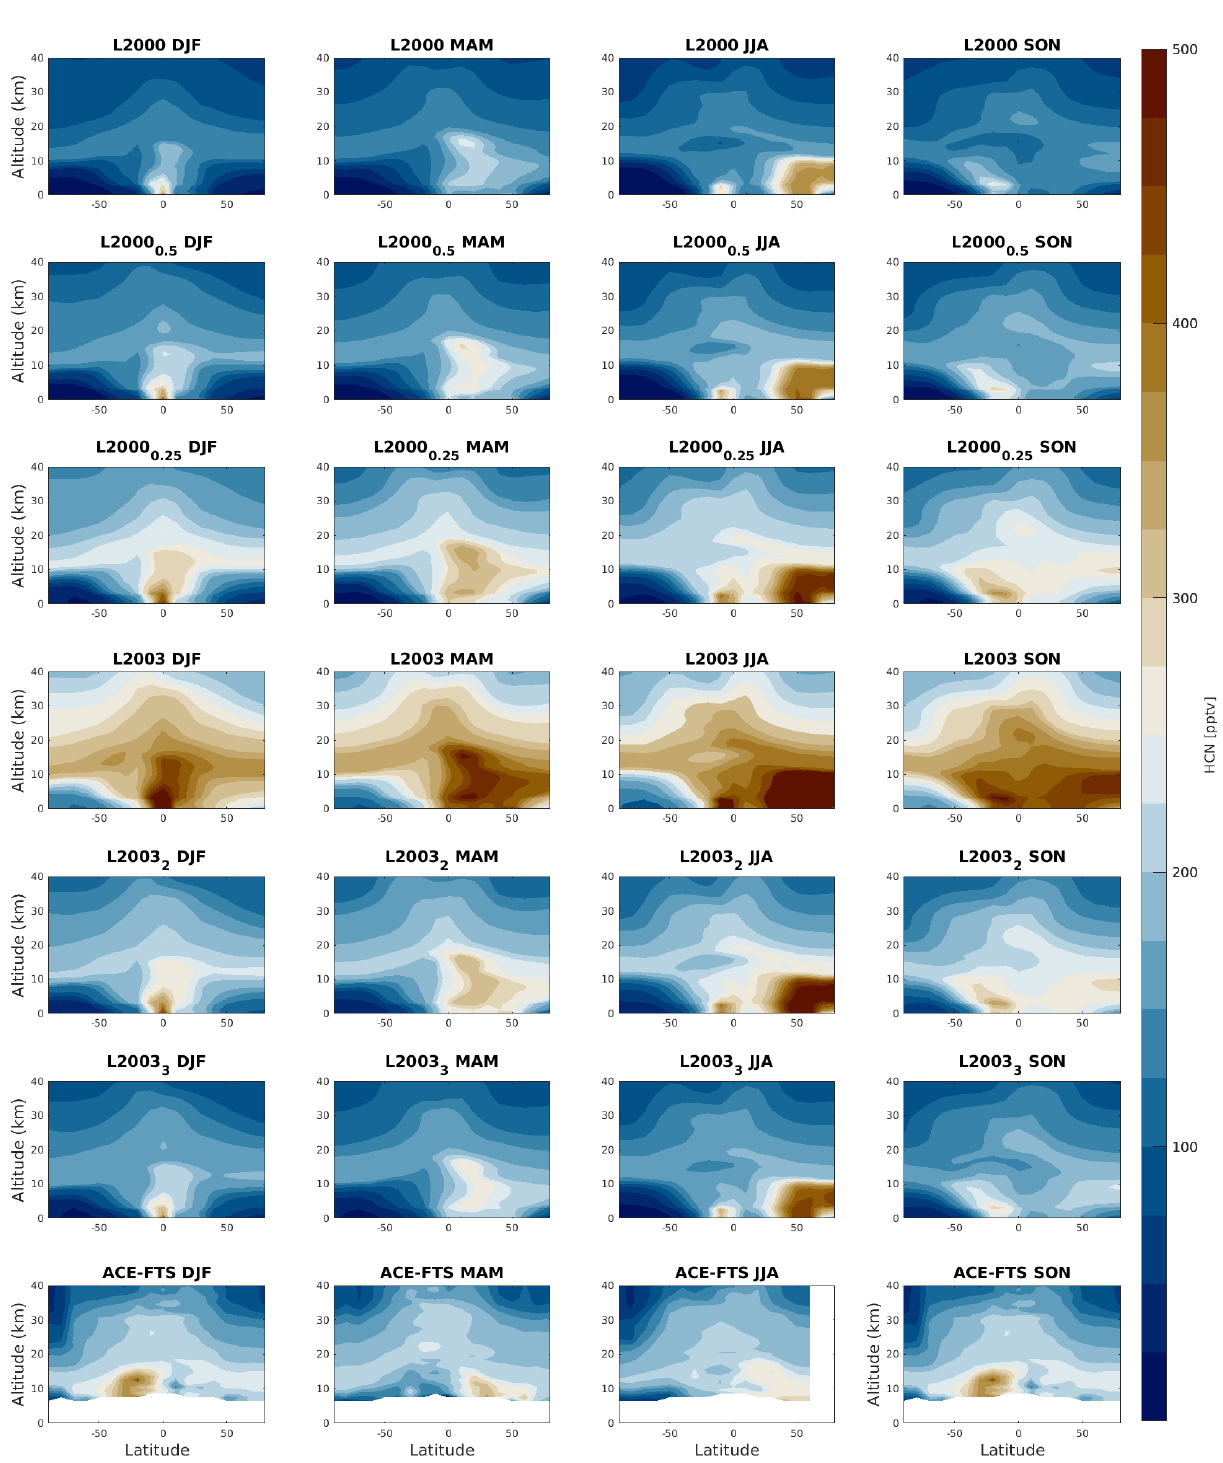
Figure 6. Seasonal mean latitude–height zonal mean cross sections from December 2008 to November 2009 of HCN zonal means in 10 ◦ latitude bins for six TOMCAT HCN tracers and ACE-FTS measurements (on the